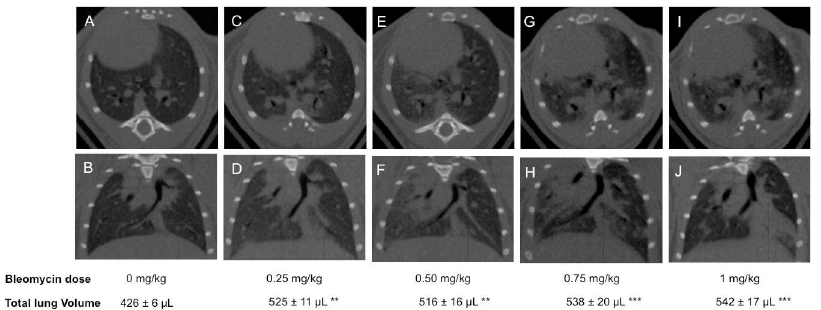
Fig 6. Representative micro-CT images of lung sections from saline control and bleomycin-treated mice. Transverse (top row) and corresponding coronal (bottom row) micro-CT images acquiredat 14 days after saline(control) (A, B) and bleomycin administration at the concentration of 0.25 mg/kg (C, D), 0.50 mg/ kg (E, F), 0.75 mg/kg (G, H) and 1mg/kg (I, J). Total lung volume is given as mean ± s.e.m. (n = 12/dosing group). ** p < 0.01, *** p < 0.001was considered statistically significantin comparisonto the non bleomycin- treated control group.